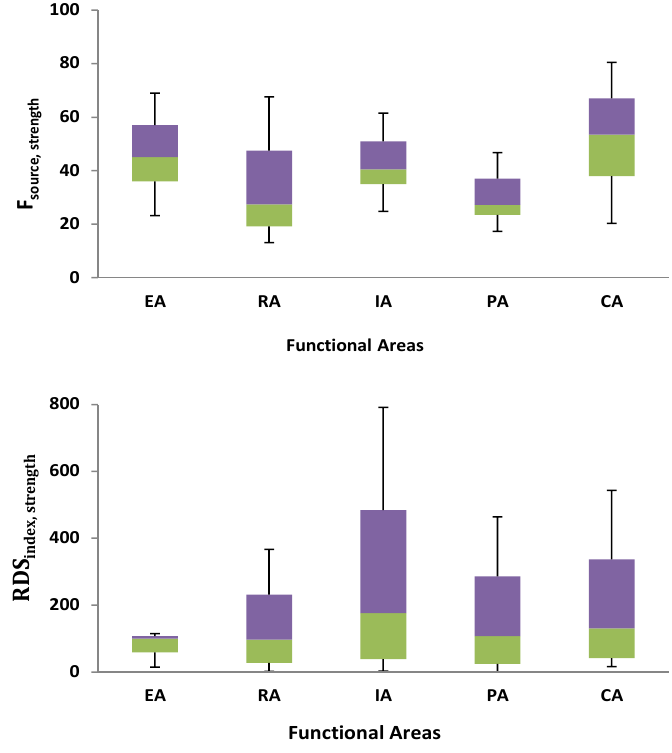
Figure 8. Box plots of the source factors and RDS index for pollution strength.